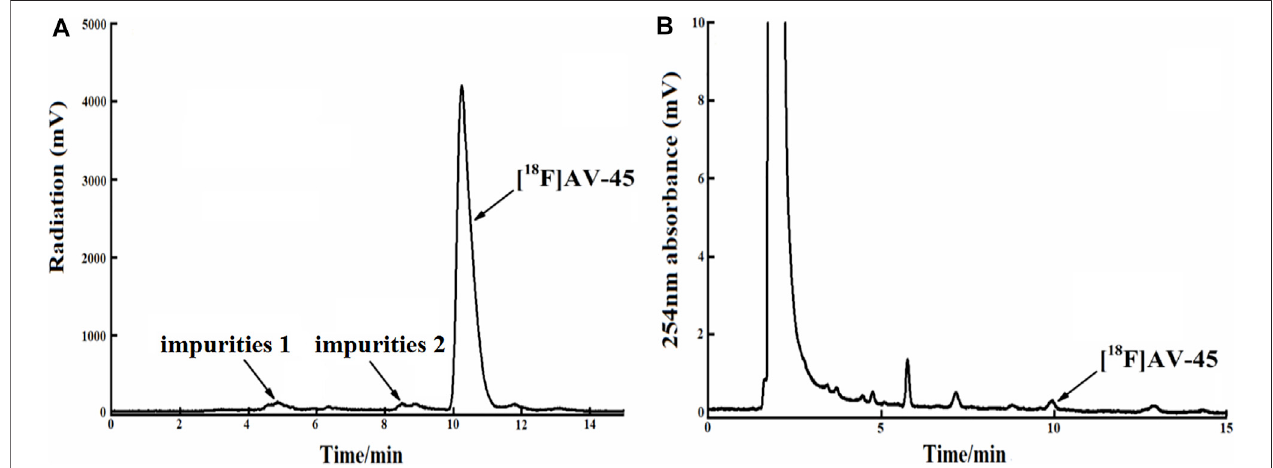
FIGURE 7 | The radiochemical purity of the preparation is 92.6% when the samples are collected until 1/4 of the peak height in the tailing edge of the radioactive peak. (A) The analytical HPLC radioactivity spectrum of fi nal product; Arrows mark the radioactive impurities and the [ 18 F] AV-45 peak. (B) The analytical HPLC UV spectrum of the fi nal product. The arrow points to the [ 18 F] AV-45 peak.